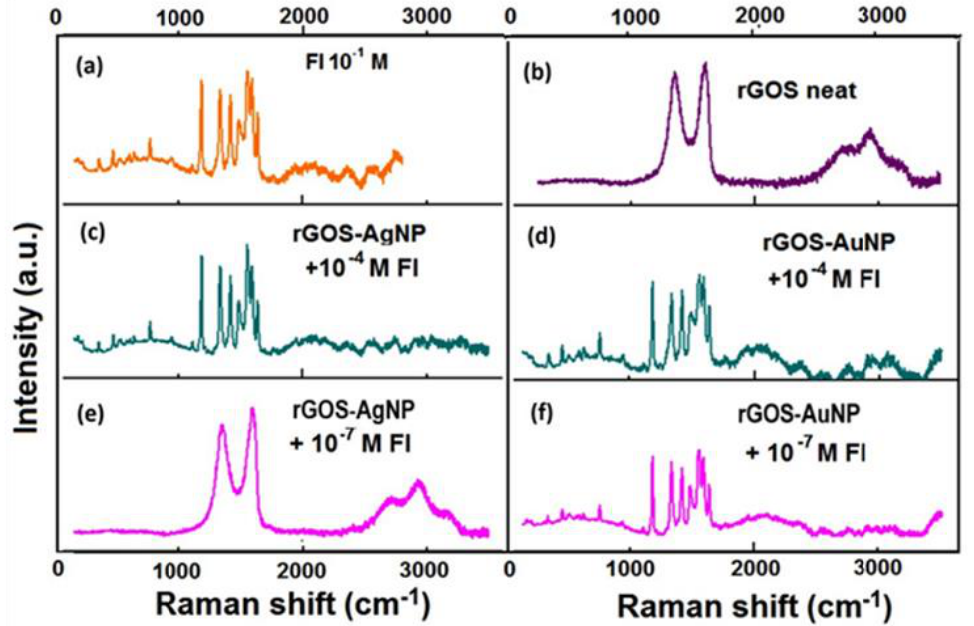
Figure 2. RAMAN spectra of Fl deposited in different concentration over the respective film: ( a ) Fl deposited from 10 −1 M solution over a glass substrate; ( b ) neat rGOS film; ( c ) Fl deposited from 10 −4 M solution over a rGOS-AgNP film; ( d ) Fl deposited from 10 −4 M solution over a rGOS-AuNP film; ( e ) Fl deposited from 10 −7 M solution over a rGOS-AgNP film; ( f ) Fl deposited from 10 −7 M solution over a rGOS-AuNP film.